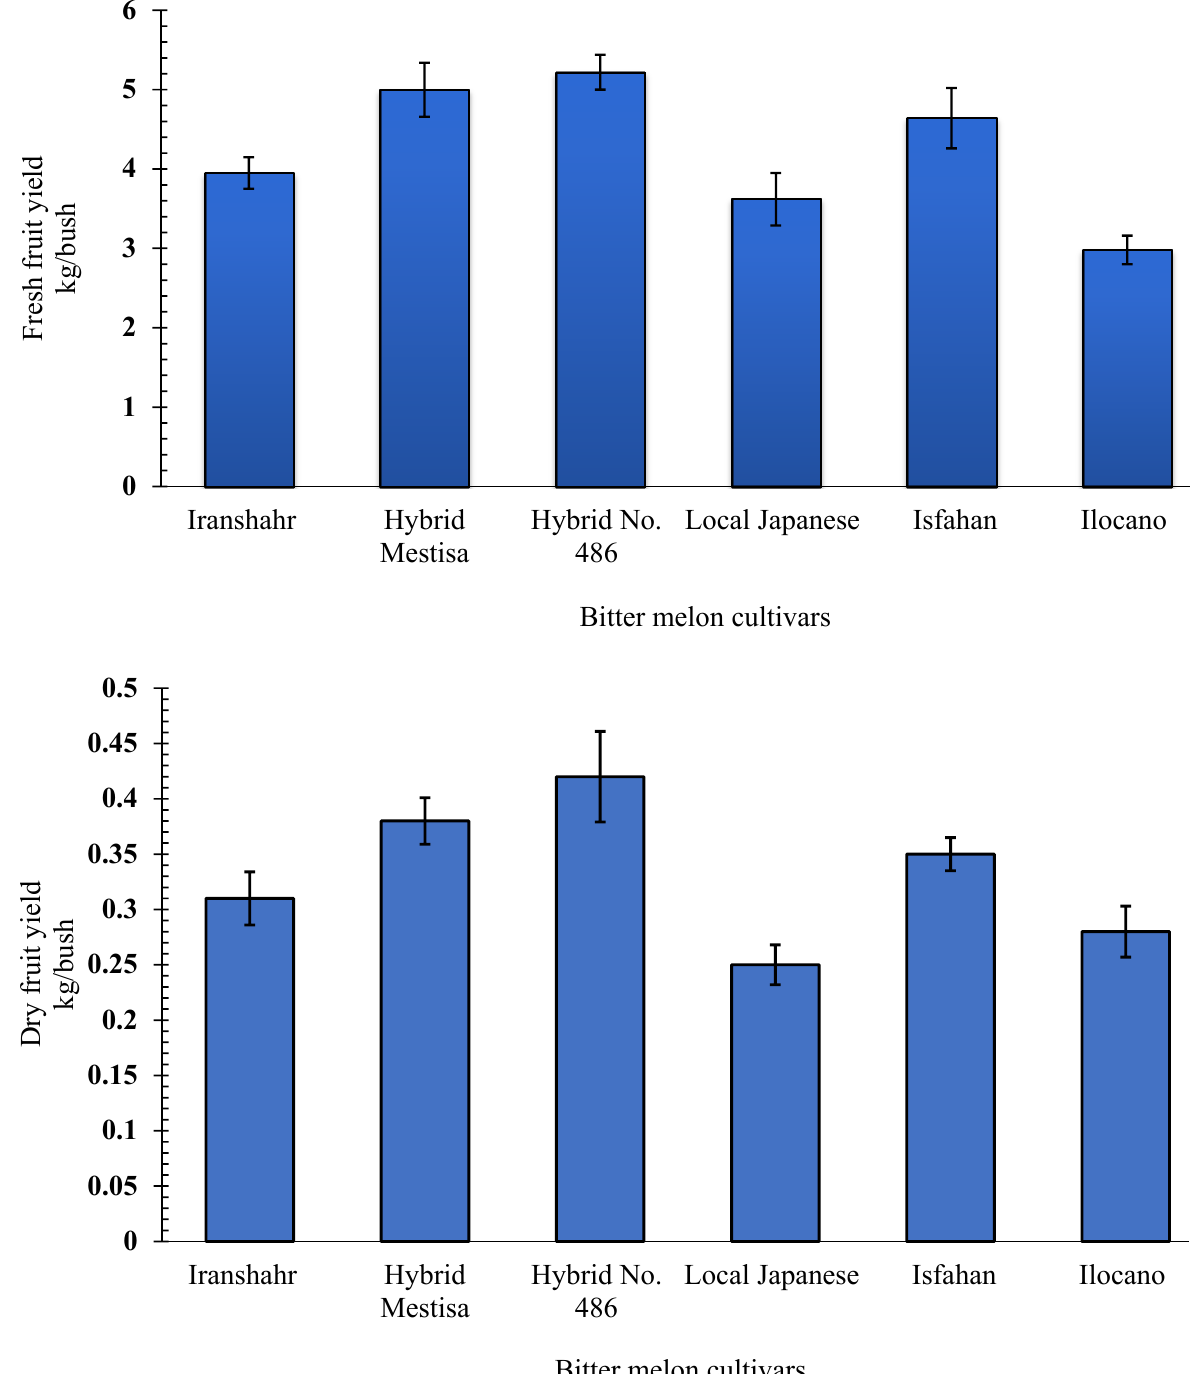
Figure 1. Fresh and dry fruit yield/plant (Immature stage) of six bitter melon cultivars grown in Karaj, Iran. Columns with the same letter are not significantly different at the 1% probability level using Tukey’s test.